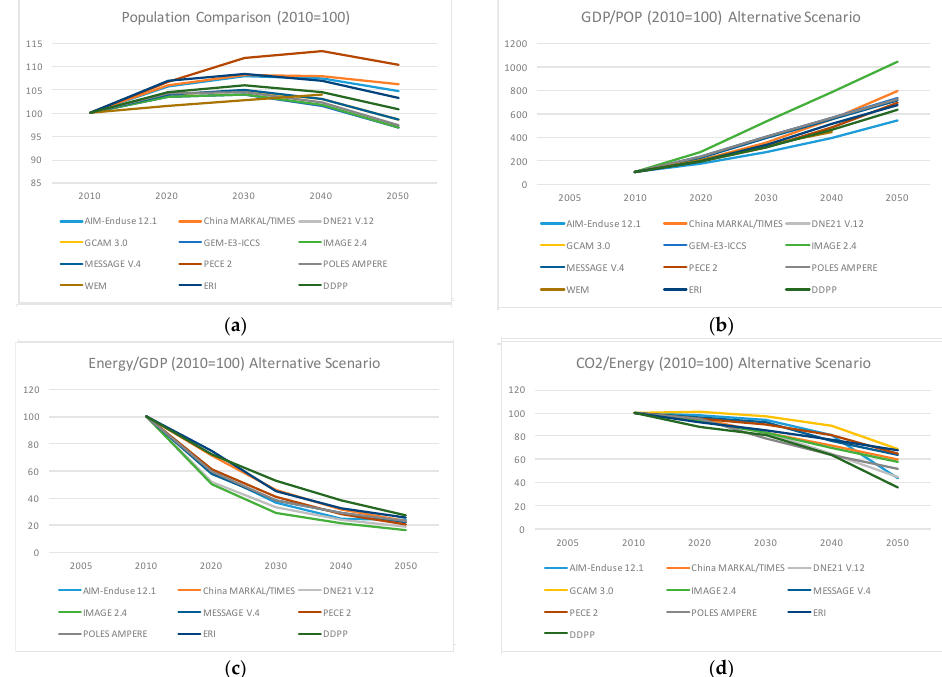
Figure 4. Comparisons of projections between 2010 and 2050 under Alternative Scenario for four key indicators. ( a ) Population growth; ( b ) per capita GDP growth; ( c ) decrease in energy intensity; and ( d ) decrease in carbon